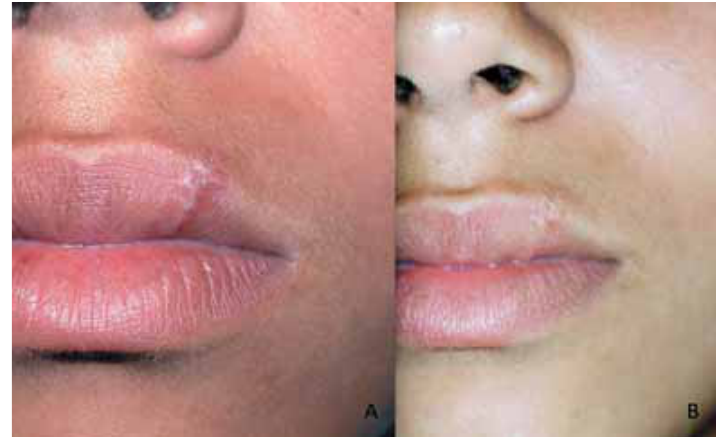
Figure 4- Labial aspect 6 months (A) and 4 years (B)